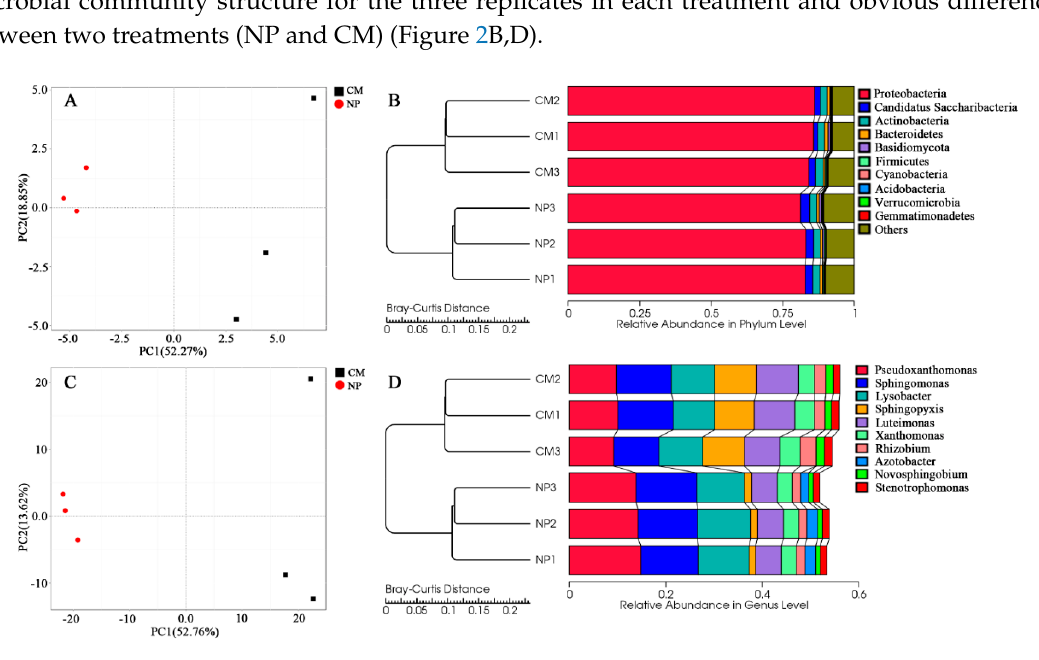
Figure 2. Classification of treatments by principal component analysis (PCA) and unweighted pair-group method with arithmetic mean (UPGMA) clustering analyses at phylum level ( A , B ) and genus level ( C , D ). NP and CM represent the one-year cultured soil and two-year consecutively monocultured soil, respectively.